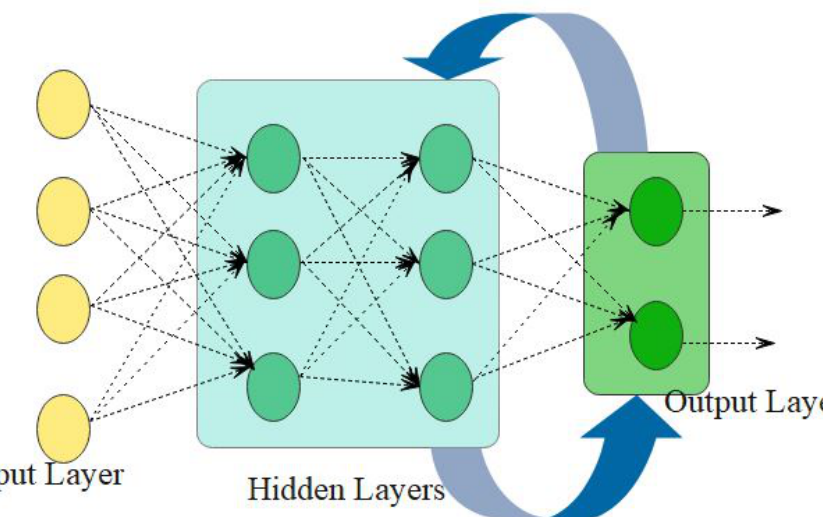
Figure 4. The Structure of Recurrent Neural Network Model.